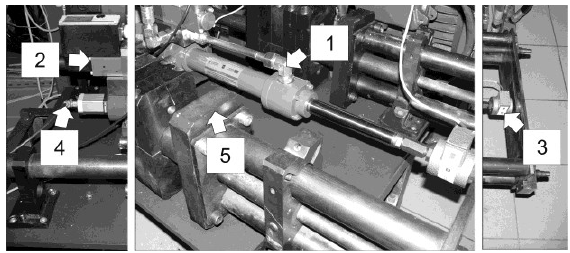
Fig. 6. View of experimental test-stand: 1 - hydraulic cylinder, 2 - proportional control valve, 3 - force transducer, 4 - position transducer, 5 - slider with the mass